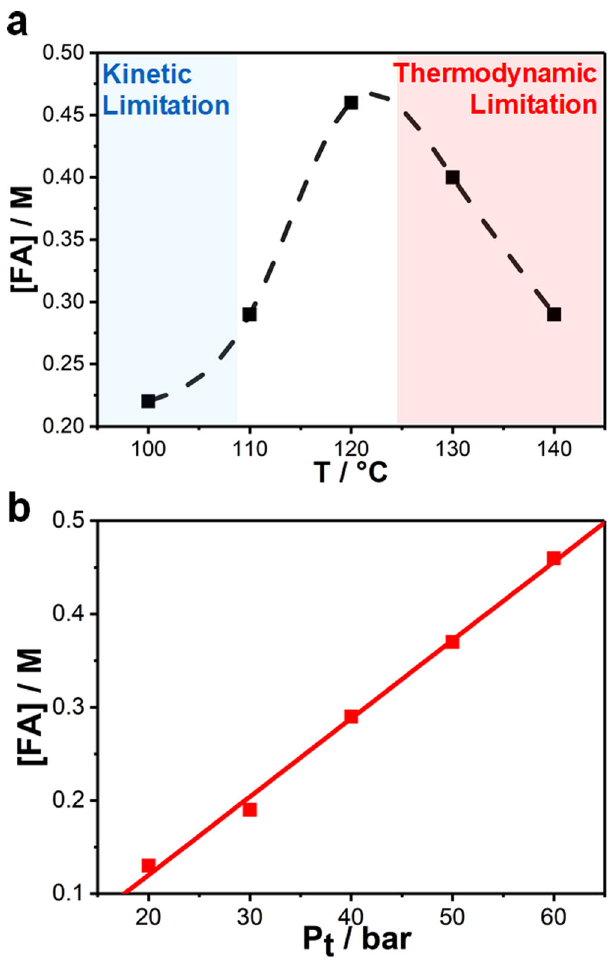
Fig. 3 Effect of temperature and pressure on concentration of formic acid synthesised. a Optimal catalytic performance as a function of temperature, where kinetic and thermodynamic limitations are observed. b Concentration of FA observed as a function of the total gas